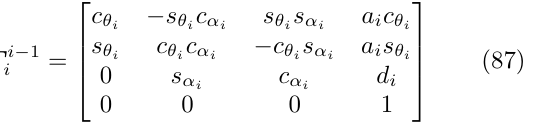
described by the Denavit-Hartenberg parameters θ , d , α and θ in Table 1.